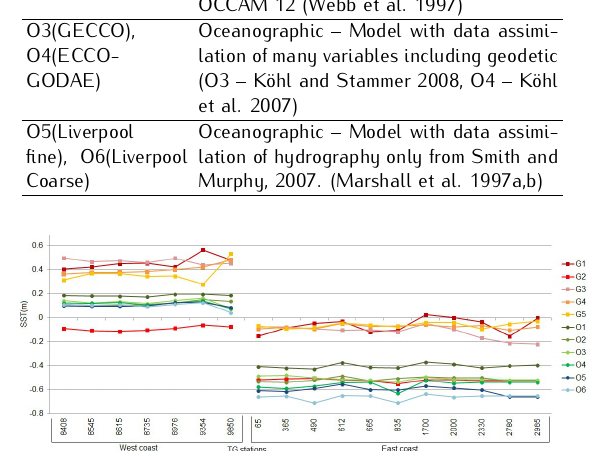
tions as the available grid is within 1 to 2 km of the coastline due to the double re-tracking effort in the altimeter data (ibid